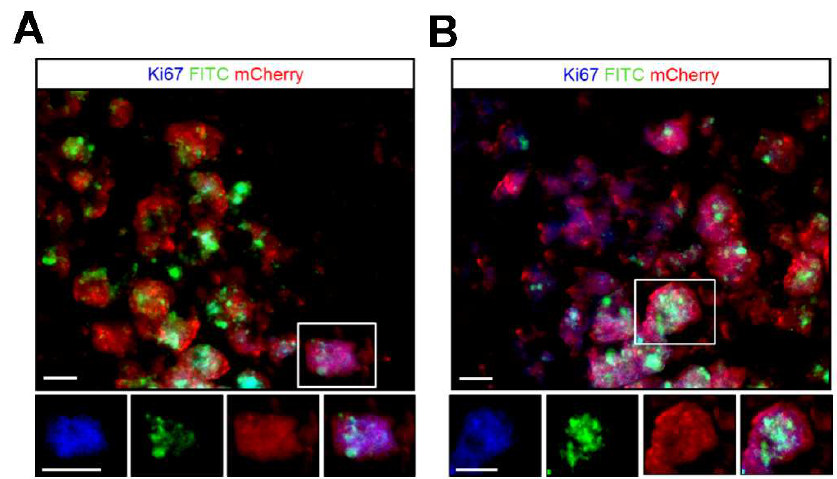
Figure 8. The survival and proliferation of the transplanted MIEG labeled MSCs at the injury site. 14 days post transplantation, the survival of the MIEG labeled MSC-mCherry ( A ) and MIEG labeled MSC-FGF21 ( B ) at the injury site was examined via mCherry immunoreactivity (red) that overexpress by the viable MSCs. The proliferation ability of the viable MSCs was examined via Ki67 immunoreactivity (blue). The majority of FITC (green) positive cells are viable MSCs. Examples of Ki67+/mCerry+/FITC+ cells are indicated by white box and represented by single channel images (lower panel). Scale bars: 100 μm.